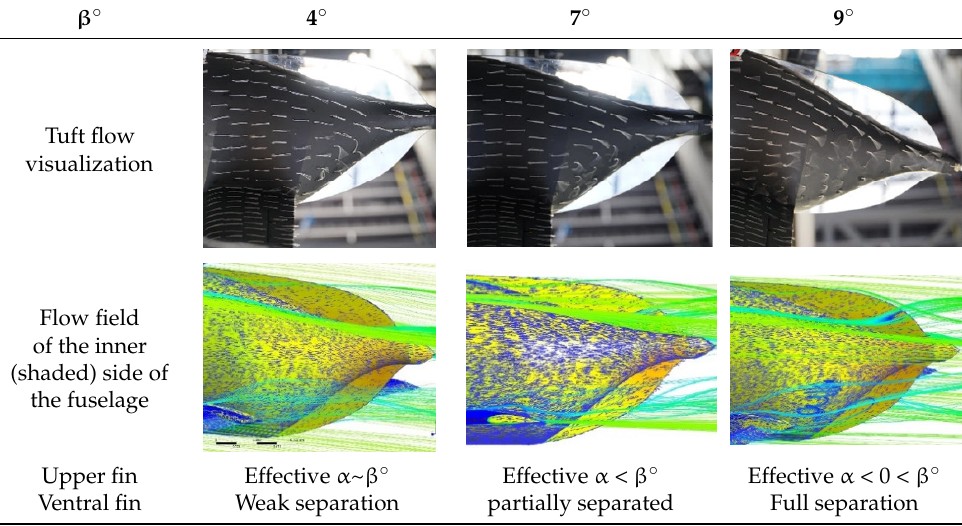
Table 2. Computed and tuft-visualized flow field near the aft fuselage and large vertical fins. β ◦ 4 ◦ 7 ◦ 9 ◦